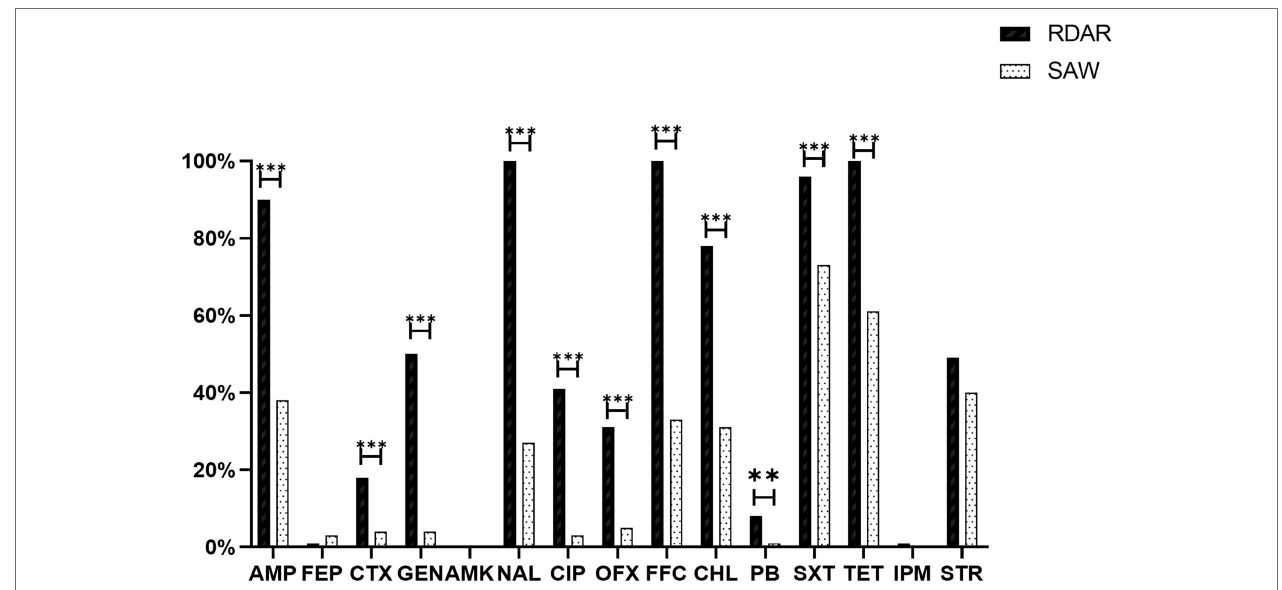
FIGURE 4 | Antimicrobial resistance of isolates and different phenotype colonies. AMP, Ampicillin; FEP, Cefepime; CTX, Cefotaxime; GEN, Gentamicin; AMK, Amikacin; NAL, Nalidixic acid; CIP, Ciprofloxacin; OFX, Ofloxacin; FFC, Florfenicol; CHL, Chloramphenicol; PB, Polymyxin B; SXT, Sulfaisoxazole; TET, Tetracycline; IPM, Imipenem; and STR, Streptomycin ( ** p < 0.01 and *** p <